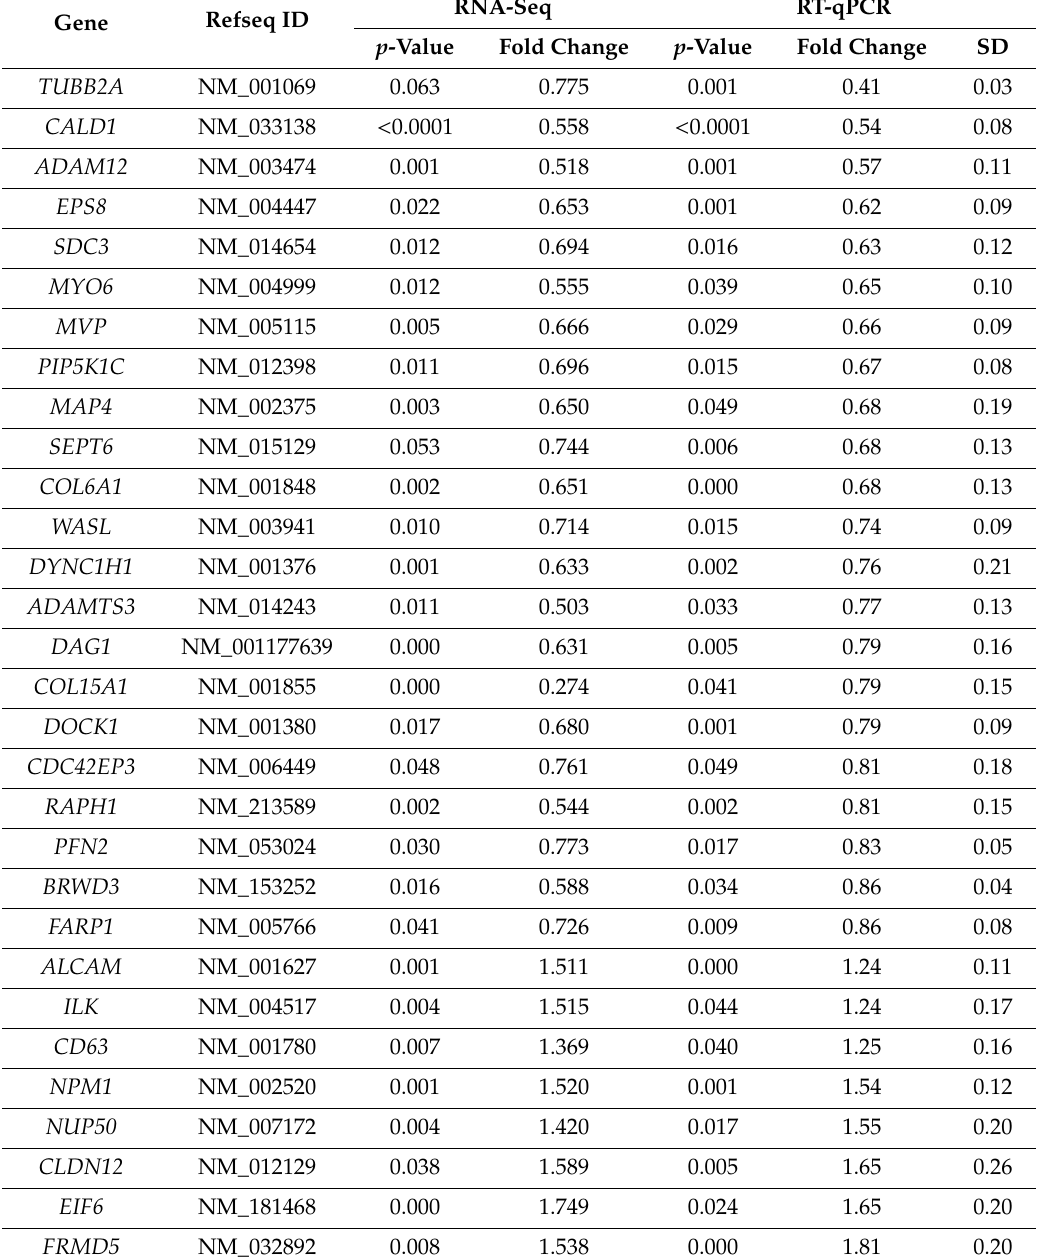
Table 1. List of di ff erentially expressed transcripts in RNA-Seq survey encoding proteins involved in cytoskeleton organization validated in RT-qPCR assay. The significance of di ff erences between control andPROX1depletedcellswasdeterminedwith t